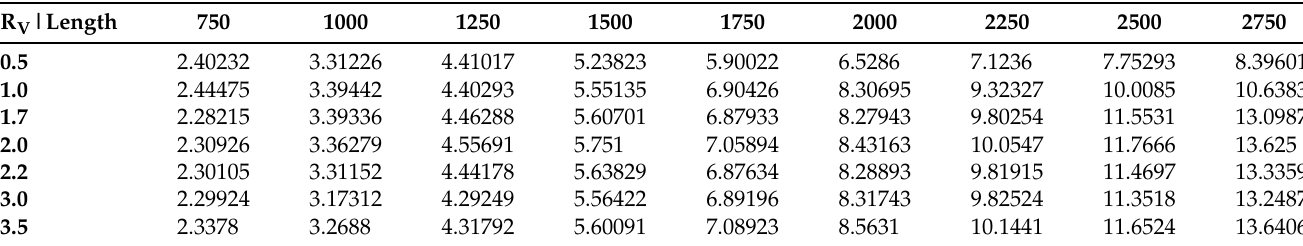
Table A9. Execution times in milliseconds on CPU with ring structure for 20,000 time-steps (1.0 s); R V on the Left and number of cells (length) on the Top .